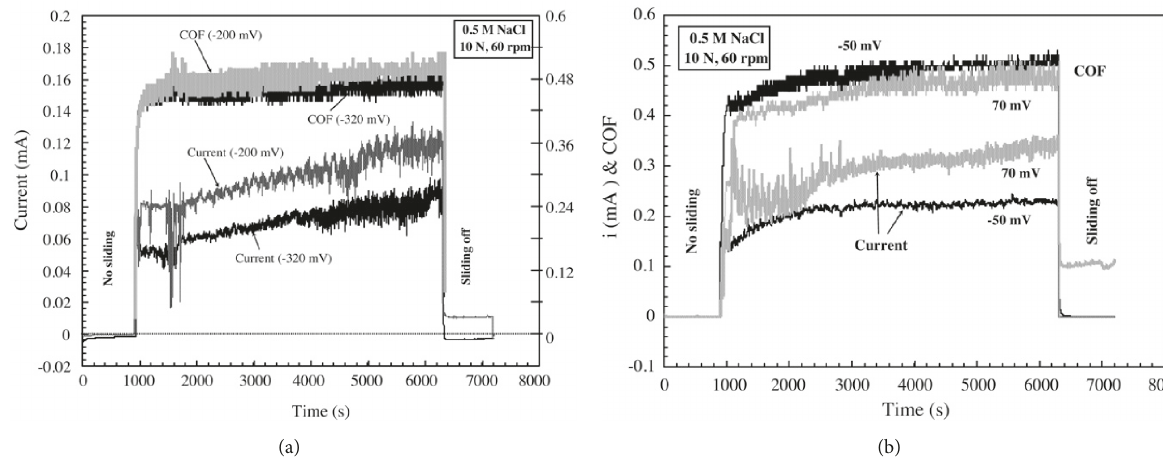
Figure 4: Current transients and coefficients of friction (COF) recorded before, during, and after sliding wear test at fixed potentials for an AISI 304 stainless steel in 0.5M NaCl solution: (a) -320 mV and -200 mV; (b) -50 mV and 70 mV. Removing the passive layer generates an increase in the current transient, with higher shifts at higher applied potentials. The coefficient of friction also varies with applied potential